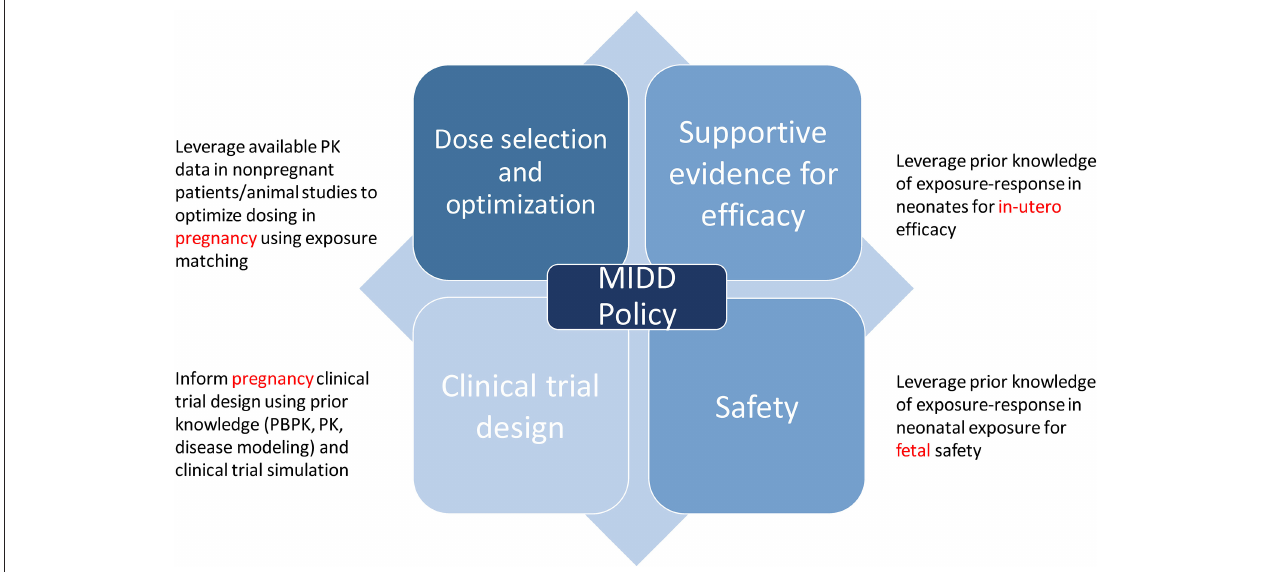
FIGURE 1 | Regulatory application of model informed drug